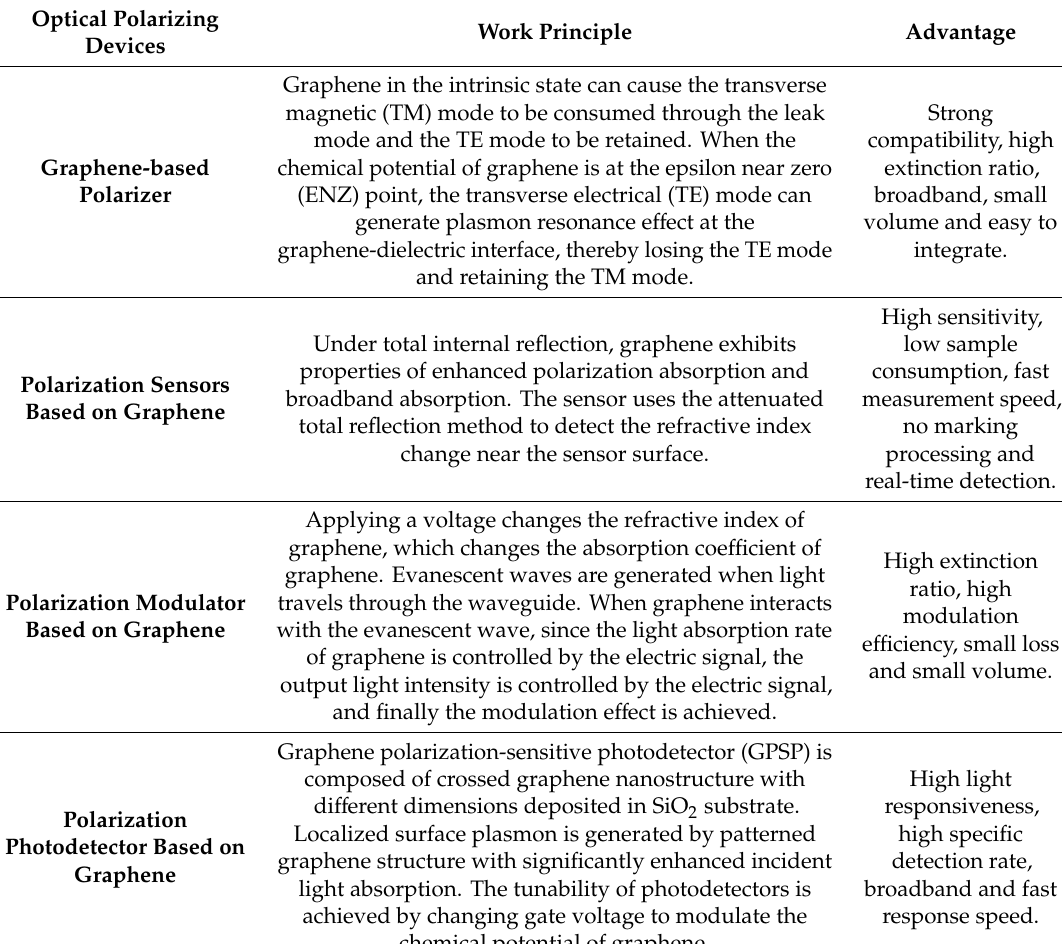
Table 1. Briefly describe the classification, working principle and advantages of graphene-based optical polarizing